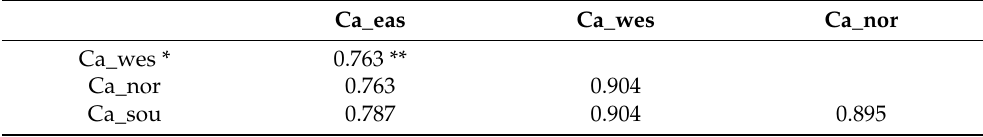
Table 1. Correlation matrix for Ca in pine #1.